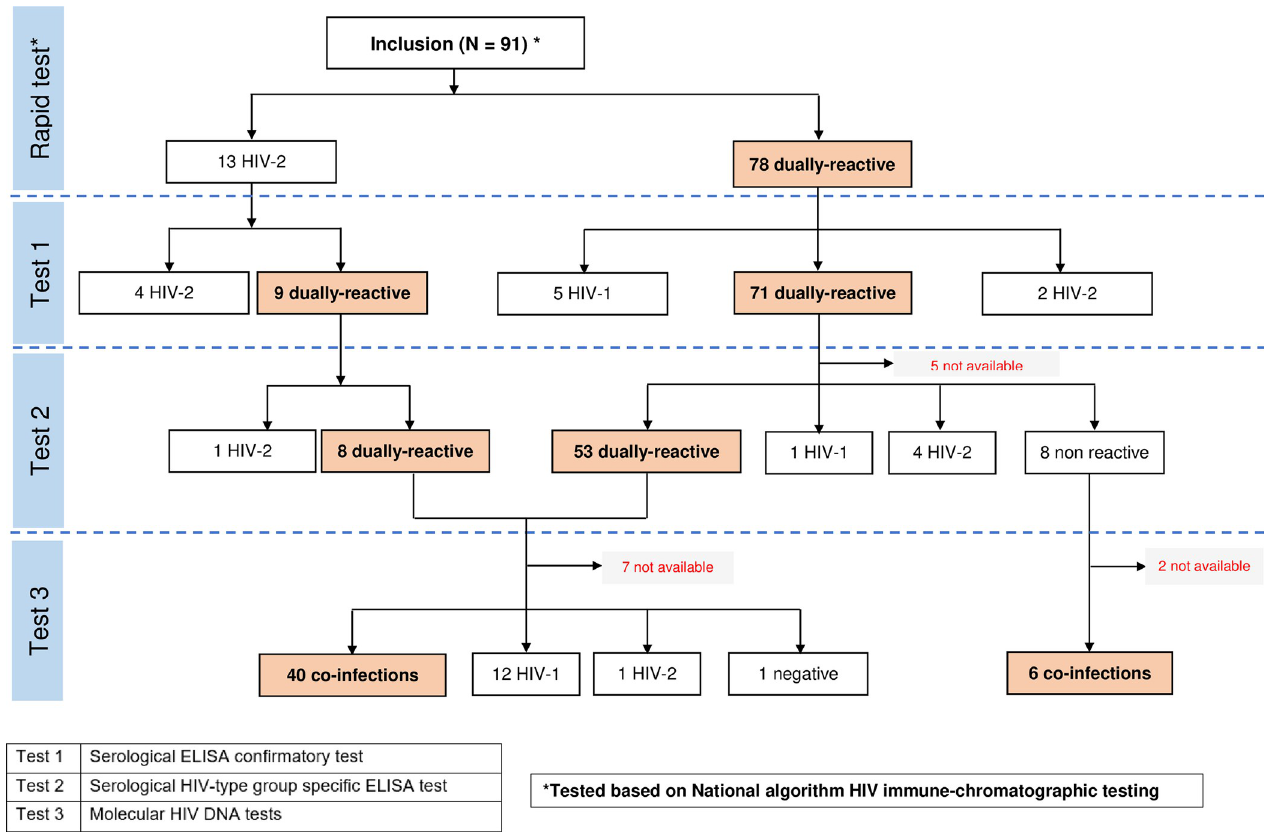
Fig 1. HIV serological and molecular testing for dually HIV-1 and HIV-2 diagnosis in West Africa.